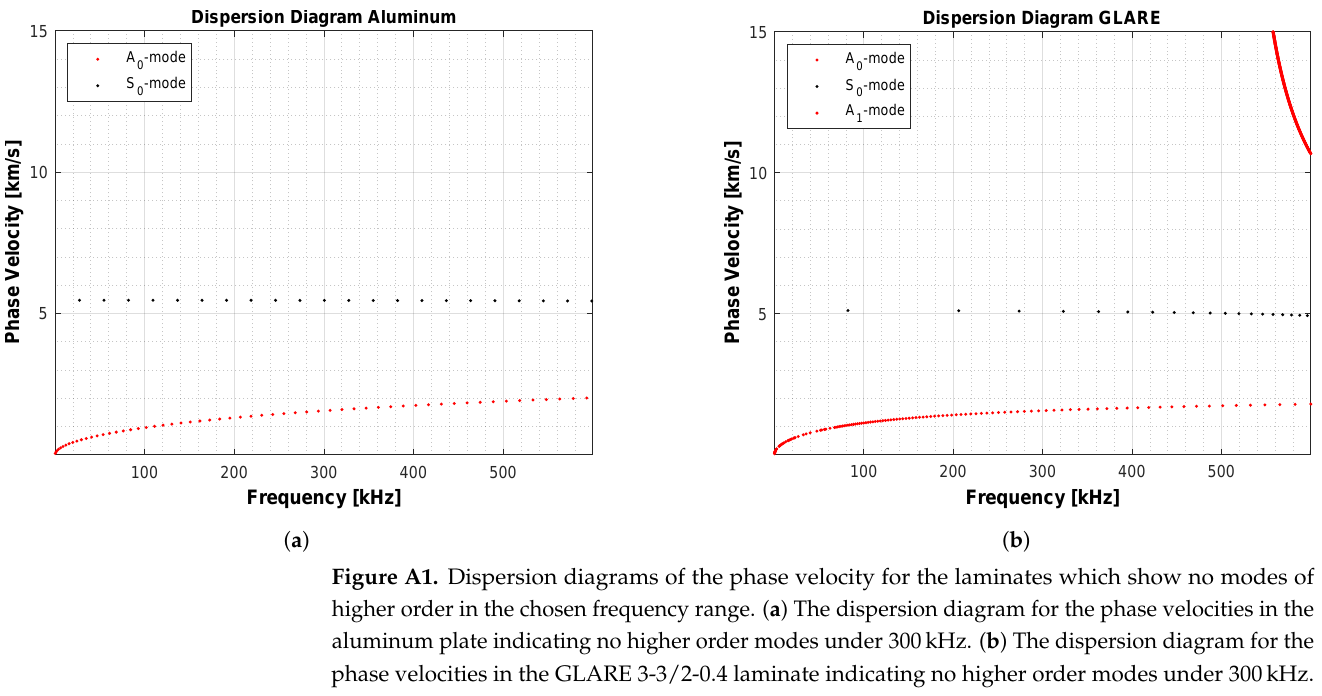
Figure A1. Dispersion diagrams of the phase velocity for the laminates which show no modes of higher order in the chosen frequency range. ( a ) The dispersion diagram for the phase velocities in the aluminum plate indicating no higher order modes under 300kHz. ( b ) The dispersion diagram for the phase velocities in the GLARE 3-3/2-0.4 laminate indicating no higher order modes under